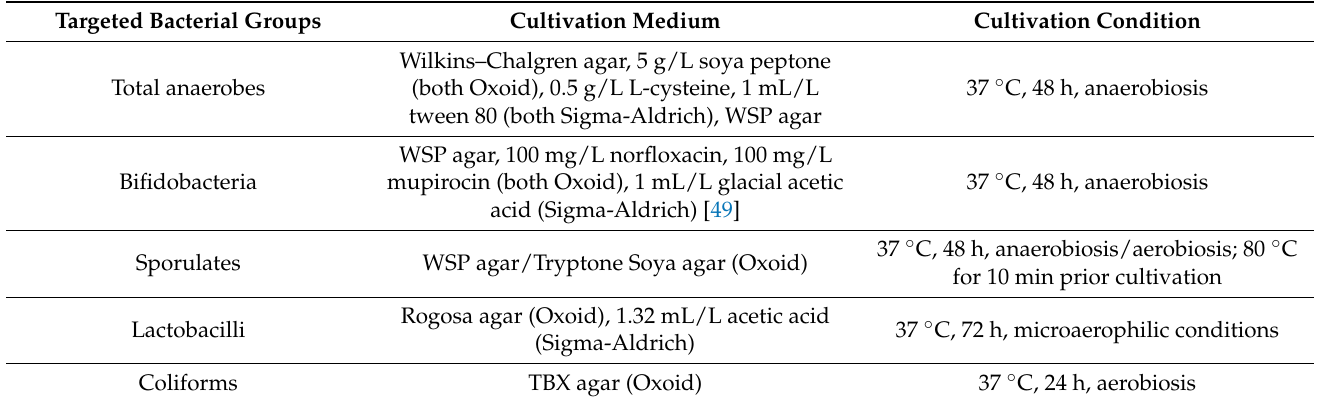
Table 1. Cultivation media and conditions used for isolation of bacteria from pig